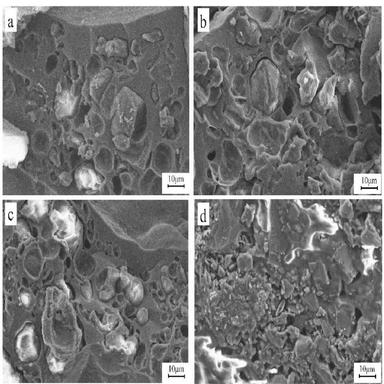
SEM images of (a) PCC500, (b) PCC700, (c) PCC900, (d) PCC1100.